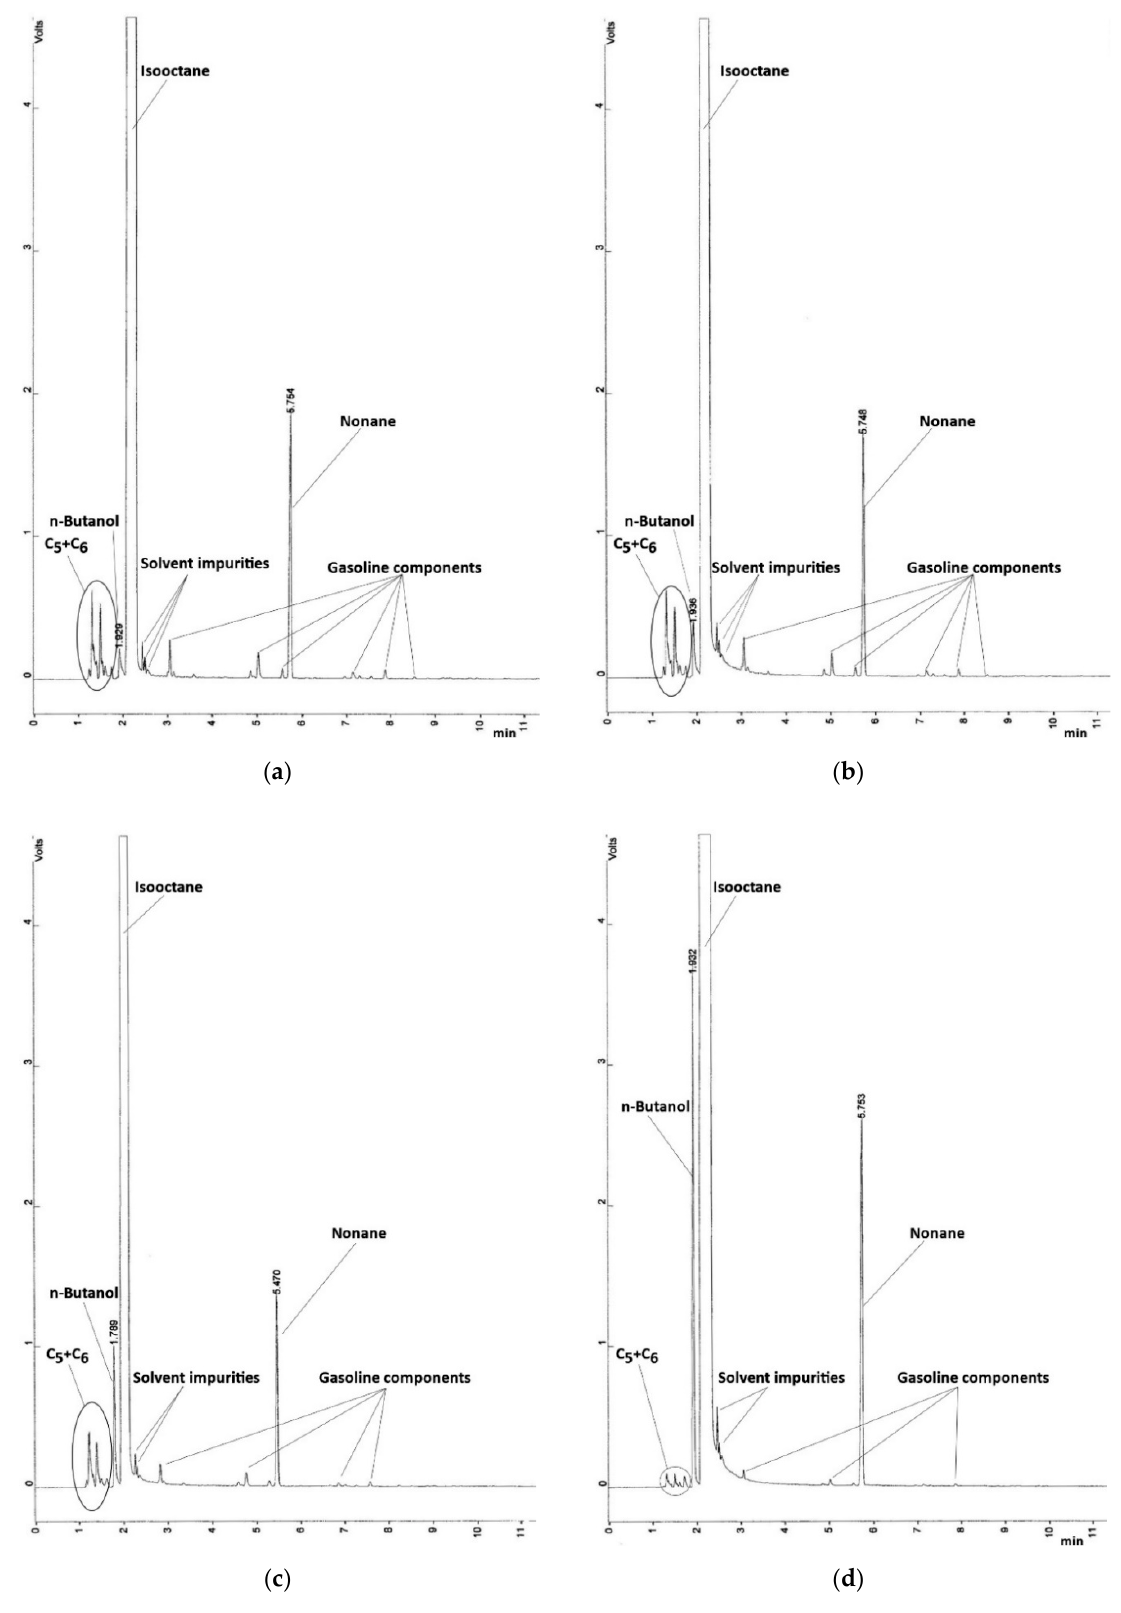
Figure 9. ( a ) Chromatogram of BUT 5 mixture; ( b ) chromatogram of BUT 10 mixture; ( c ) chromatogram of BUT 30 mixture; ( d ) chromatogram of BUT 85 mixture.